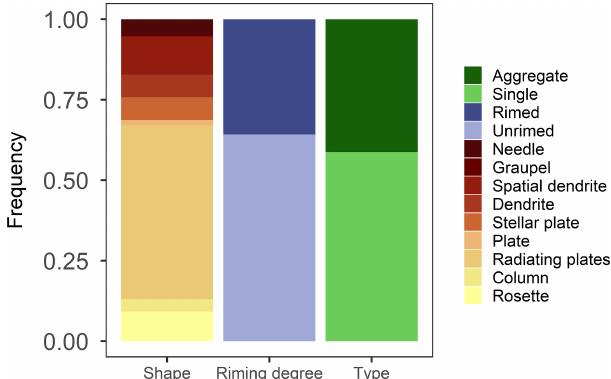
Figure 8. Analysis of (827) unequivocal ice particles that were cap- tured during the 52 snowfall events coinciding with a running mean RH ice ≥ 97% throughout the lower 2.7km. Frequency with respect to shape (i.e. as shown in Fig. 2), riming degree (i.e. unrimed or rimed), and type (i.e. single or aggregate) are